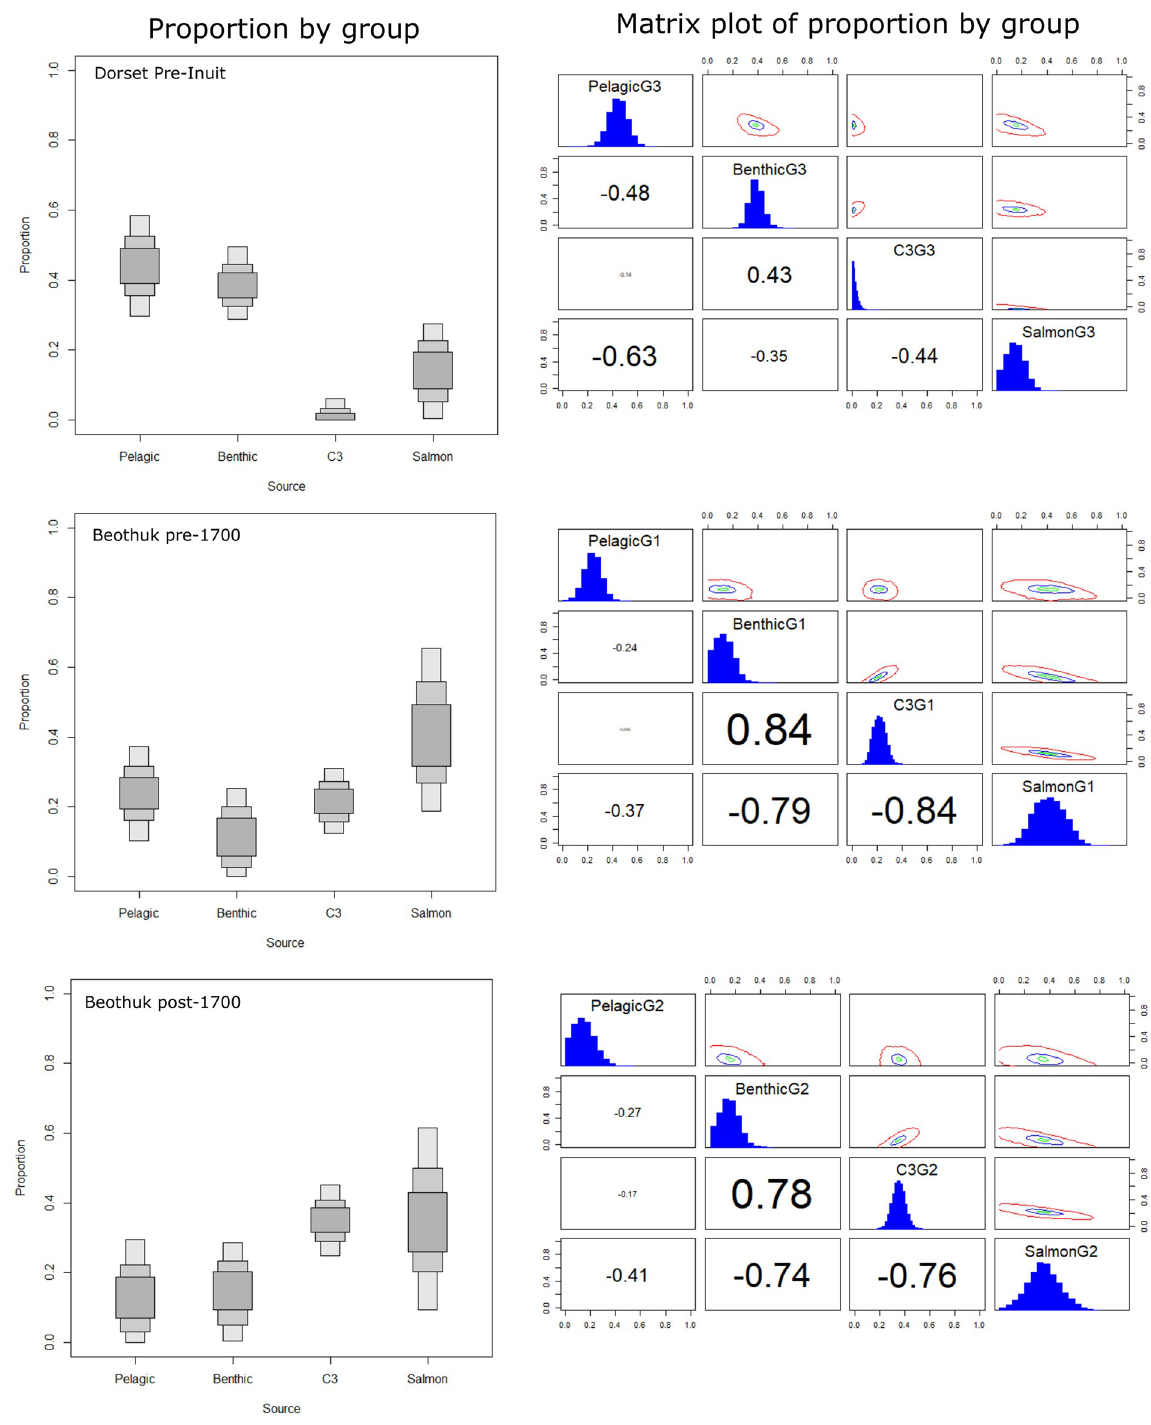
Fig 7. Estimated proportions of terrestrial (C1), pelagic (C2) and benthic (C3) food sources (left), and diagnostic matrix plots (right) for each cultural/chronological group. Model includes published human collagen isotope data from Raghavan et al. 2014, Duggan et al. 2017, and Kuch et al.